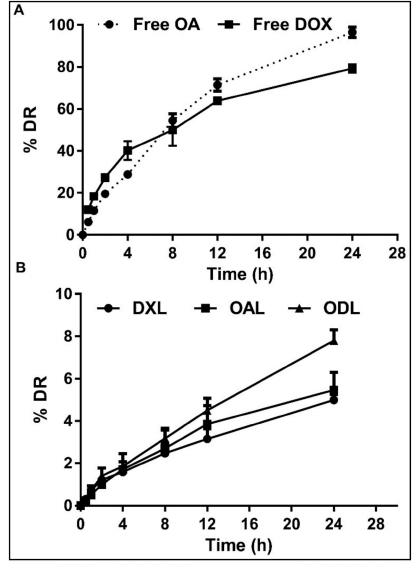
Figure 5. % drug release (%DR) in serum after 24 h ( A ) free drug ( B ) liposome loaded